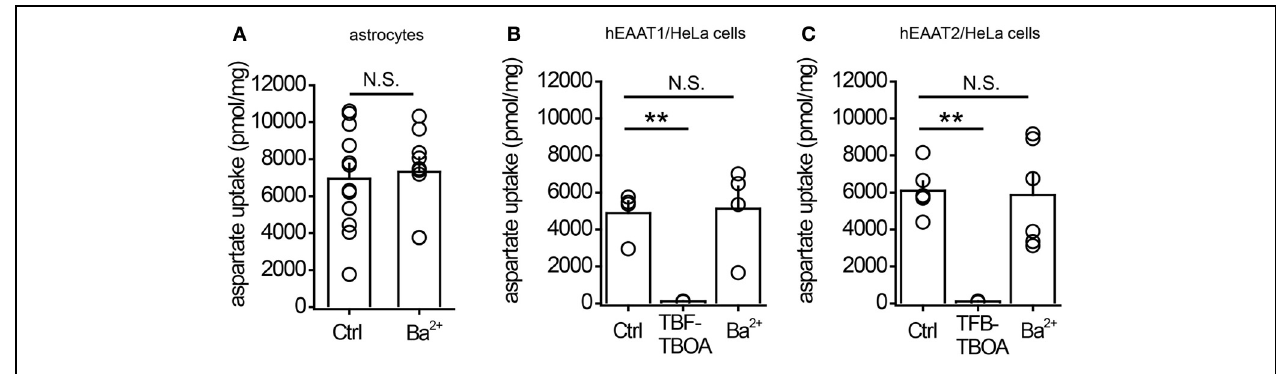
FIGURE 4 | 1 µ M Ba 2 + does not potentiate aspartate uptake by cultured astrocytes or by HeLa cells expressing glutamate transporters. (A) Summary graph of aspartate uptake by cultured astrocytes in control conditions (Ctrl) or in the presence of 1 µ M BaCl 2 (Ba 2 + ). (B) Summary graph of aspartate uptake by HeLa cells expressing